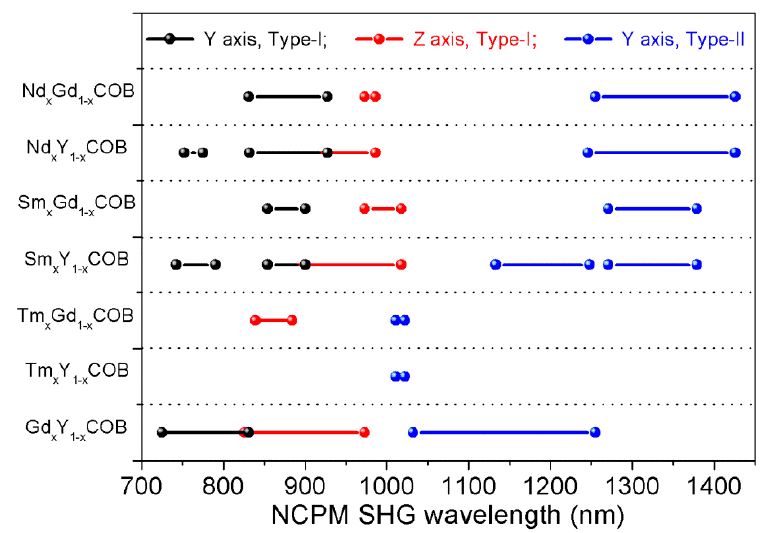
Figure 3. A- NCPM SHG wavebands of various RE1 x RE2 1 − x COB crystals. Figure 3. A-NCPM SHG wavebands of various RE1 x RE2 1 − x COB